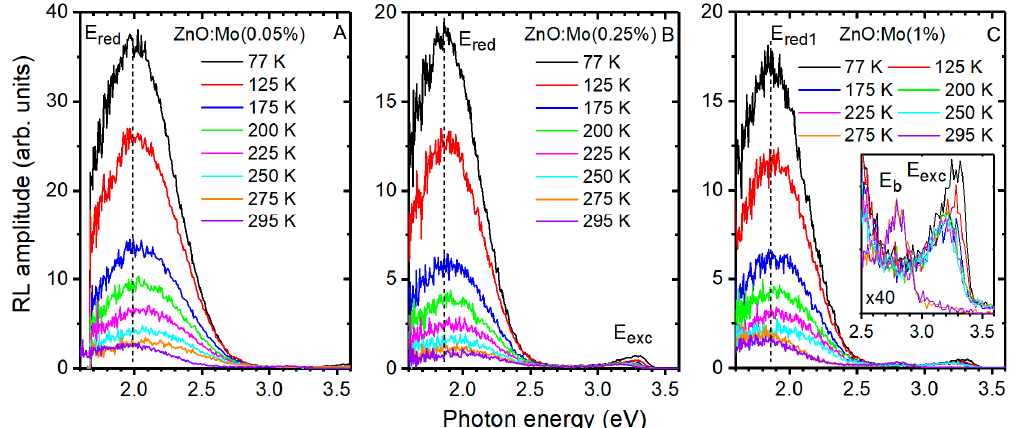
Figure 8. RL spectra of ZnO:Mo(0.05%) ( A ), ZnO:Mo(0.25%) ( B ) and ZnO:Mo(1%) (the inset demon- strates the closeup of the E b and E exc bands) ( C ) PH samples. Dashed vertical line is an eye guide for the changes in the position of the defect-related band.